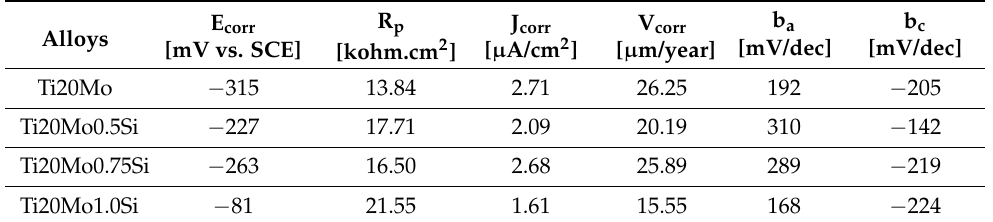
Table 3. Instantaneous corrosion parameters for Ti–Mo–Si alloys in Ringer’s